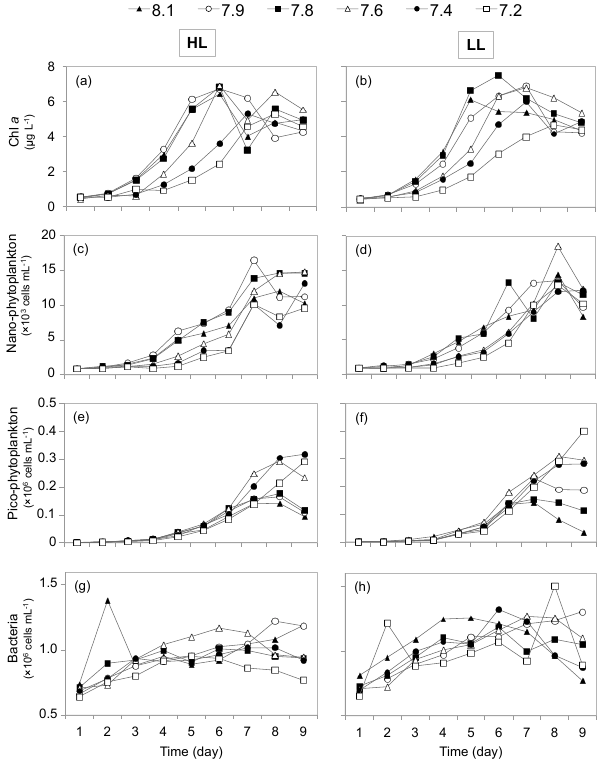
Figure 4. Temporal variations in (a, b) chlorophyll a (Chl a) con- centration, (c, d) nano-phytoplankton, (e, f) pico-phytoplankton, and (g, h) bacteria during the microcosm experiment. Left and right panels show variations under the high light (HL) and low light (LL) treatments, respectively. Each curve represents a microcosm identi- fied by its mean pH T value.